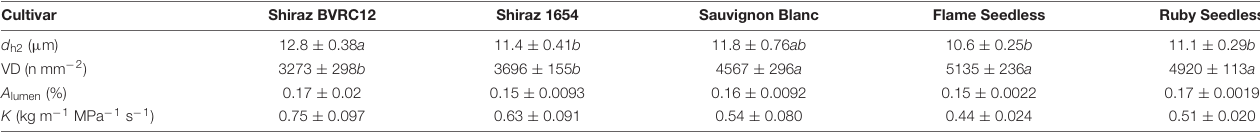
TABLE 1 | Receptacle xylem vessel mean hydraulically weighted diameter ( d h2 ) (semi-automatically segmented), vessel density (VD), relative lumen area ( A lumen ), and total potential area-specific hydraulic conductivity ( K ) of Shiraz BVRC12, Shiraz 1654, Sauvignon Blanc, Flame Seedless, and Ruby Seedless from season 2018–2019.